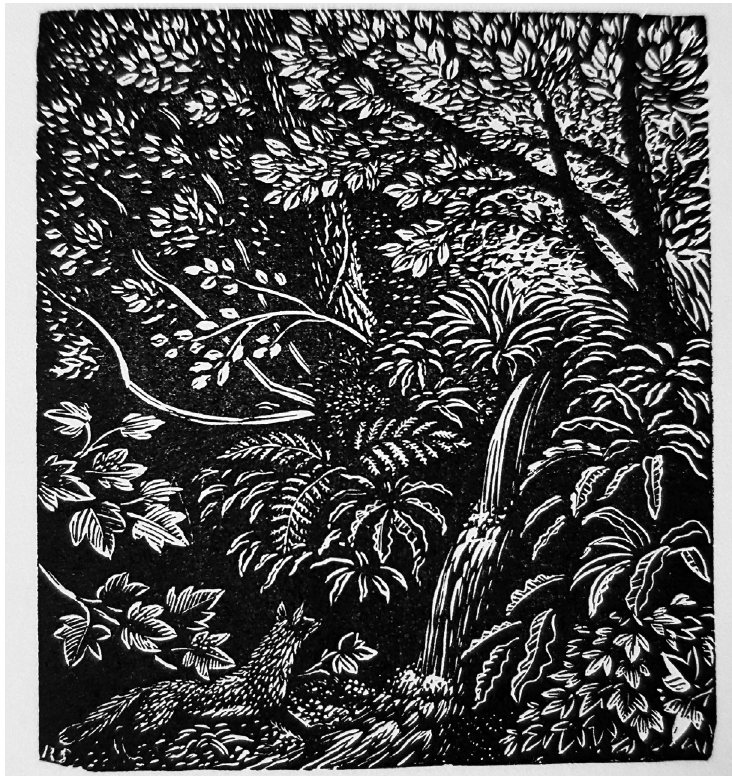
Figure 3 Illustration for Boxwood poem I. Image courtesy of the Estate of Reynolds